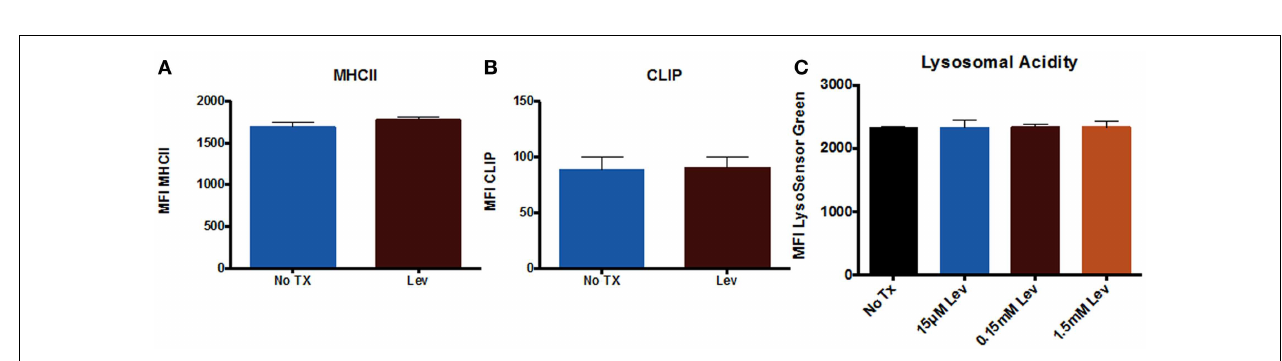
splenocytes 48h after treatment with or without Lev. (C) MFI Lysosensor Green as a relative measure of lysosomal acidity of splenocytes 48h after treatment with Lev. *Denotes a p -value <